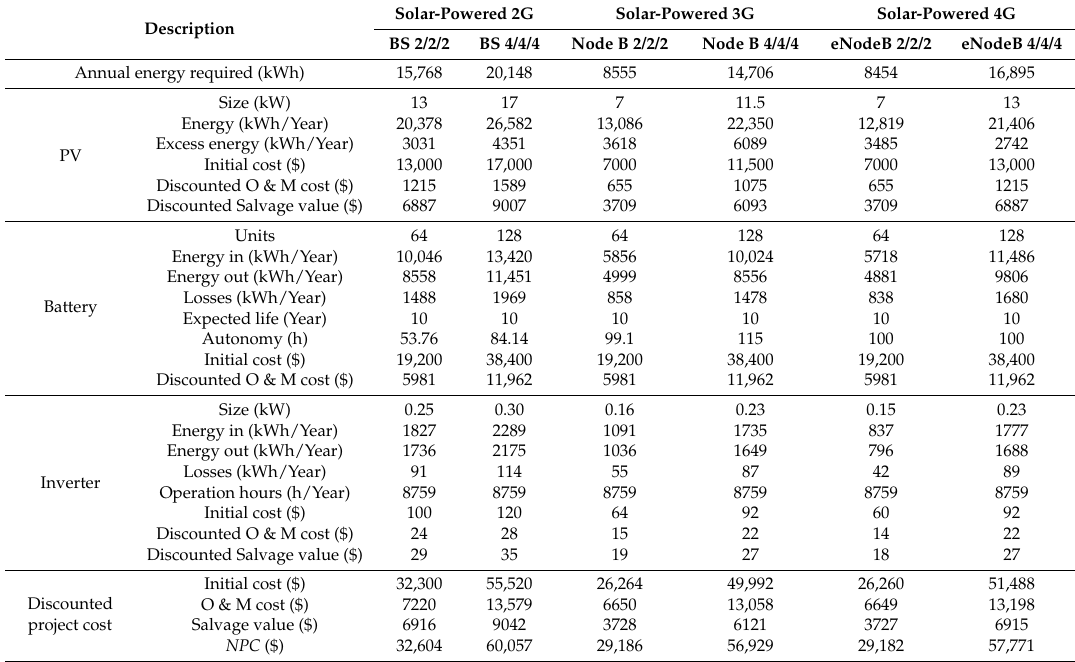
Table 3. Summary of optimal criteria for the solar-powered base stations (BSs) for different generations of mobile